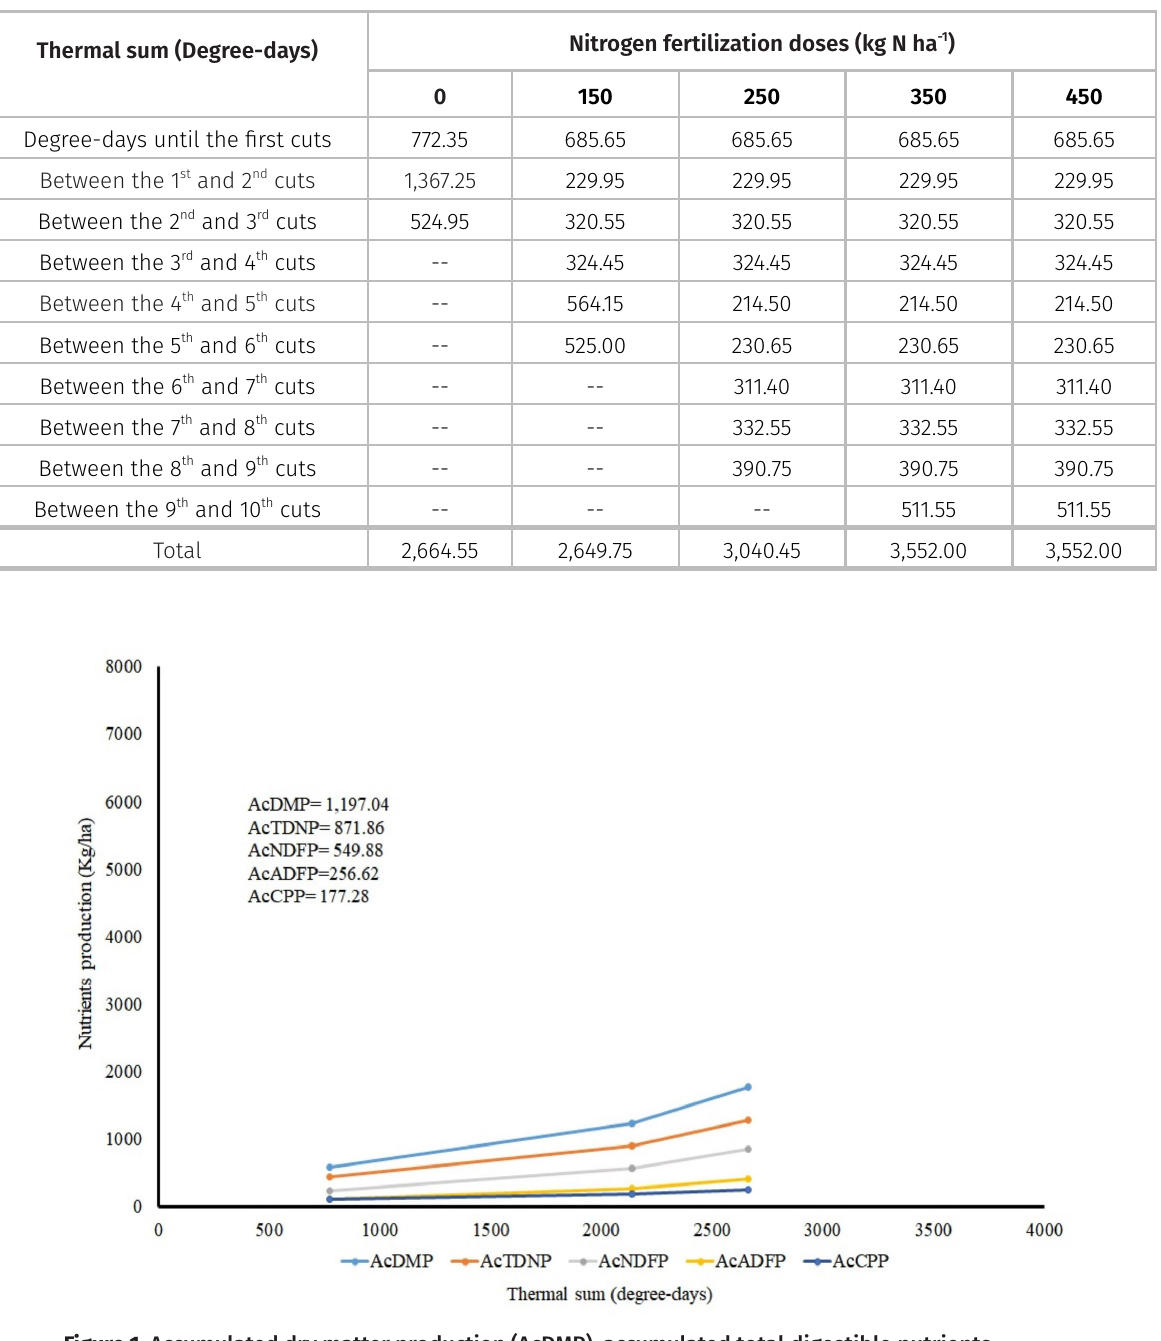
Figure 1. Accumulated dry matter production (AcDMP), accumulated total digestible nutrients production (AcTDNP), accumulated neutral detergent fiber production (AcNDFP), accumulated acid detergent fiber production (AcADFP), and cumulative crude protein production (AcCPP) per ha for dual-purpose wheat pasture of BRS Tarumã managed without nitrogen topdressing